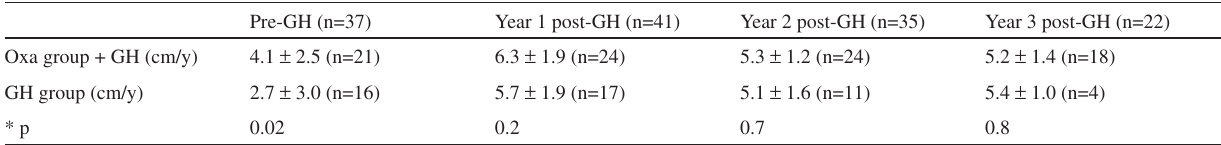
Table 2 - Growth velocity in TS girls before and after treatment with GH alone or associated with oxandrolone (Mean ±